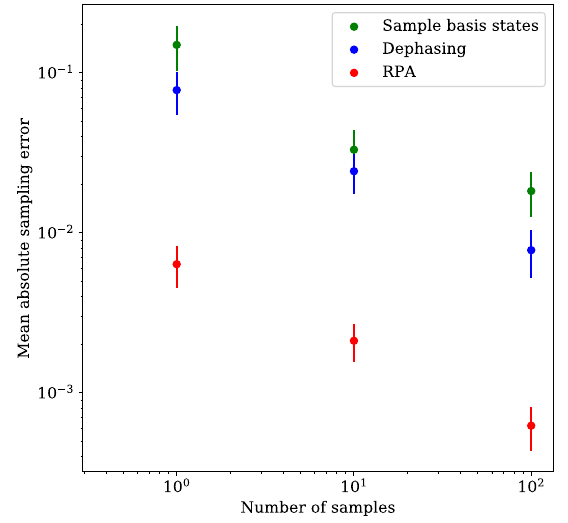
FIG. 7. The sampling error present in the random-phase- approximation, dephasing, and basis state sampling methods described in the main text, for the 11-qubit system with 40 second-order Trotter steps. Each point is the average of 20 values taken in the interval [0, 10 ) μ s.